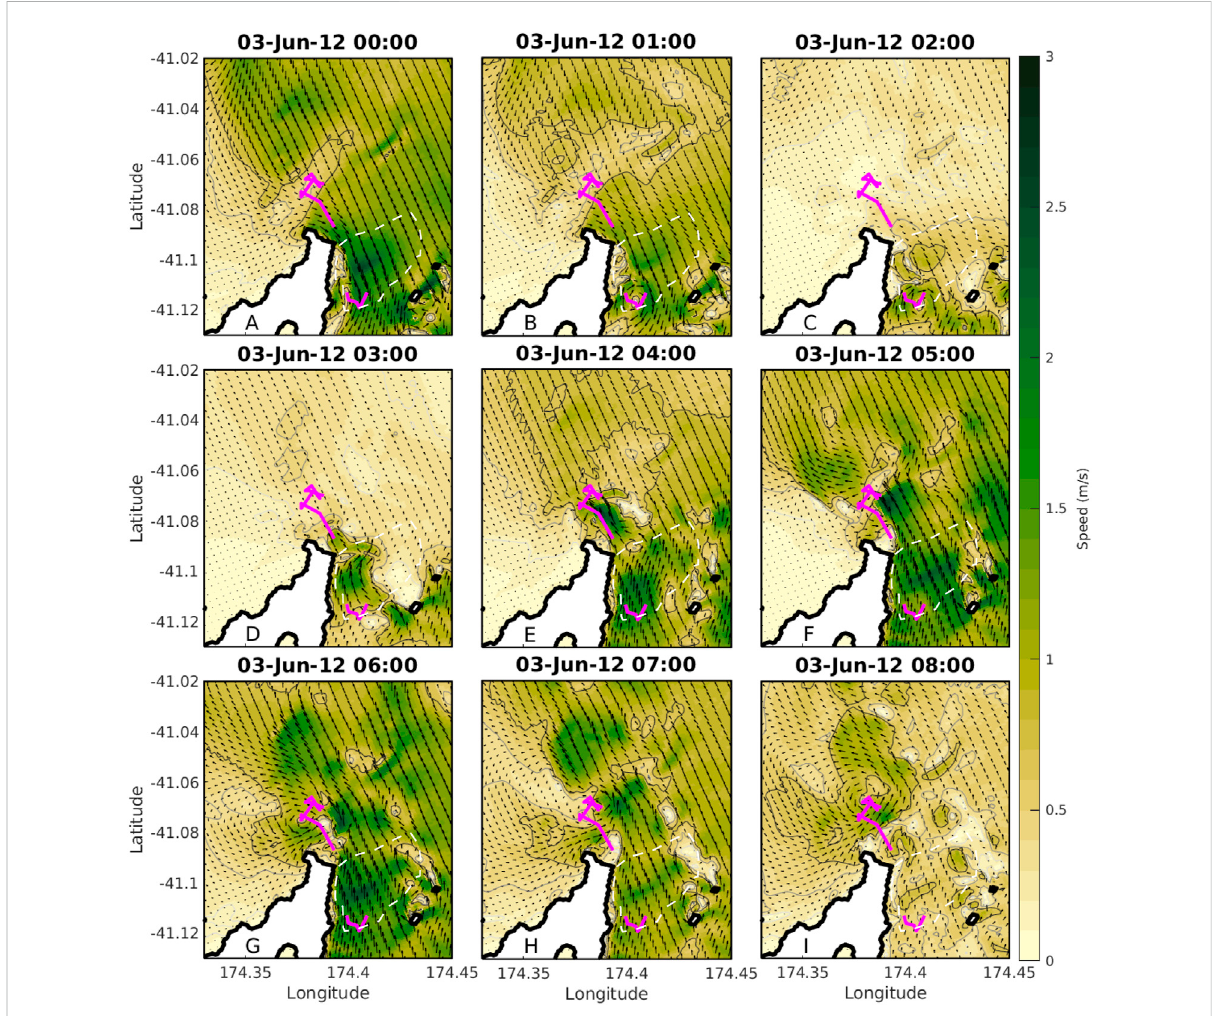
FIGURE 9 Snapshots of modelled near-bottom currents over one tidal cycle (date and time indicated in title of each panel). Colourscale shows current speed,blackarrowsarecurrent fl owvectorsandindicatedirectionof fl ow.Magentalinesshowthepathoftwoeddiesformedbythetidal fl ow.White dashed lines outline the area where the bedforms are located (see Figure 1 for